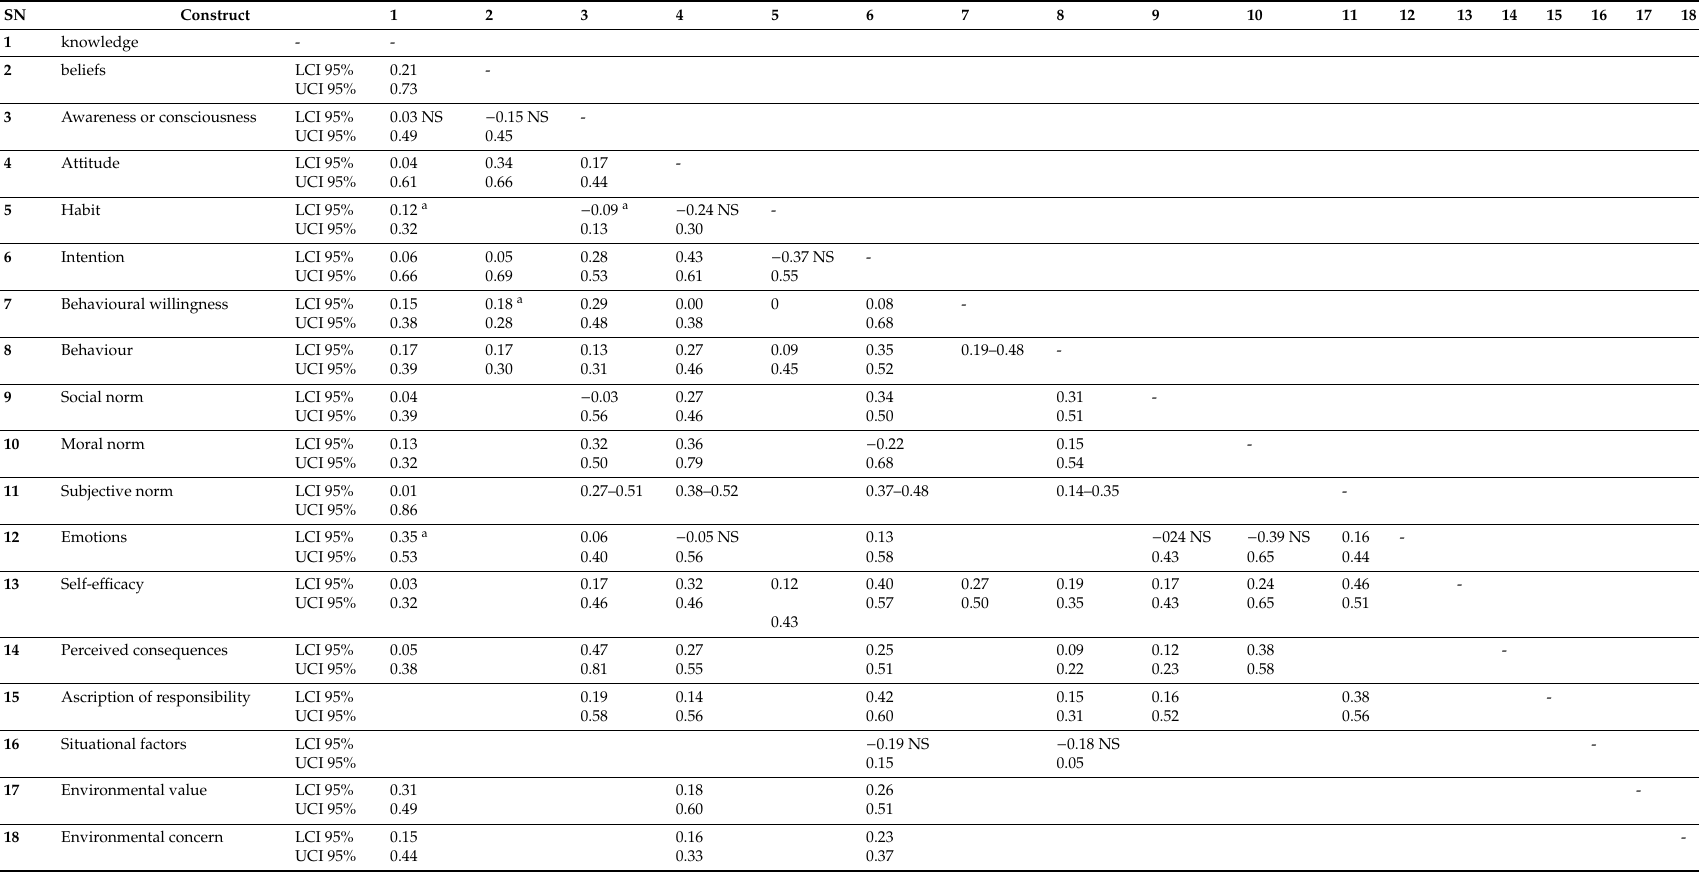
Table A2. A 95%-confidence interval of the correlations calculated under the random e ff ect assumptions